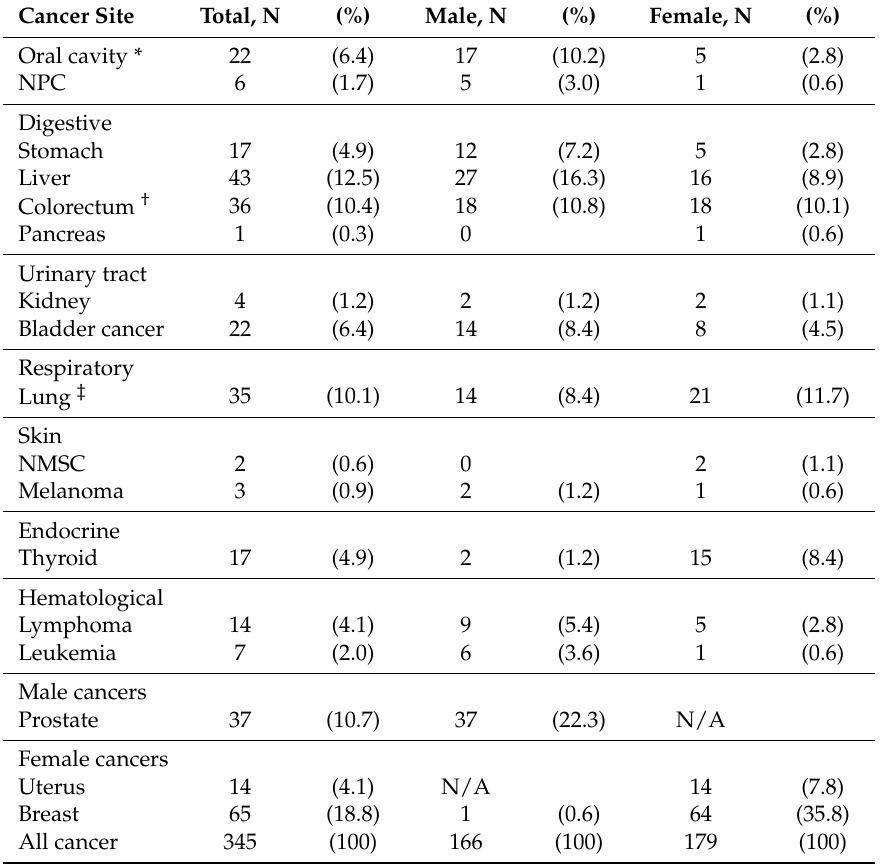
Table 2. Types of post-vitiligo